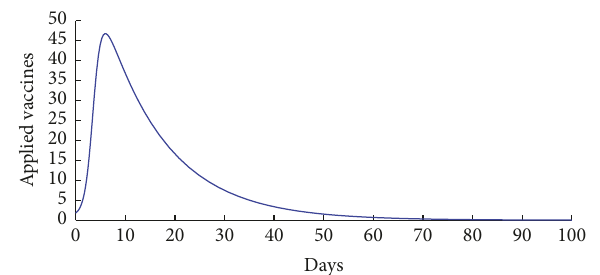
Figure 9: Evolution of the vaccines applied during the vaccination campaign.